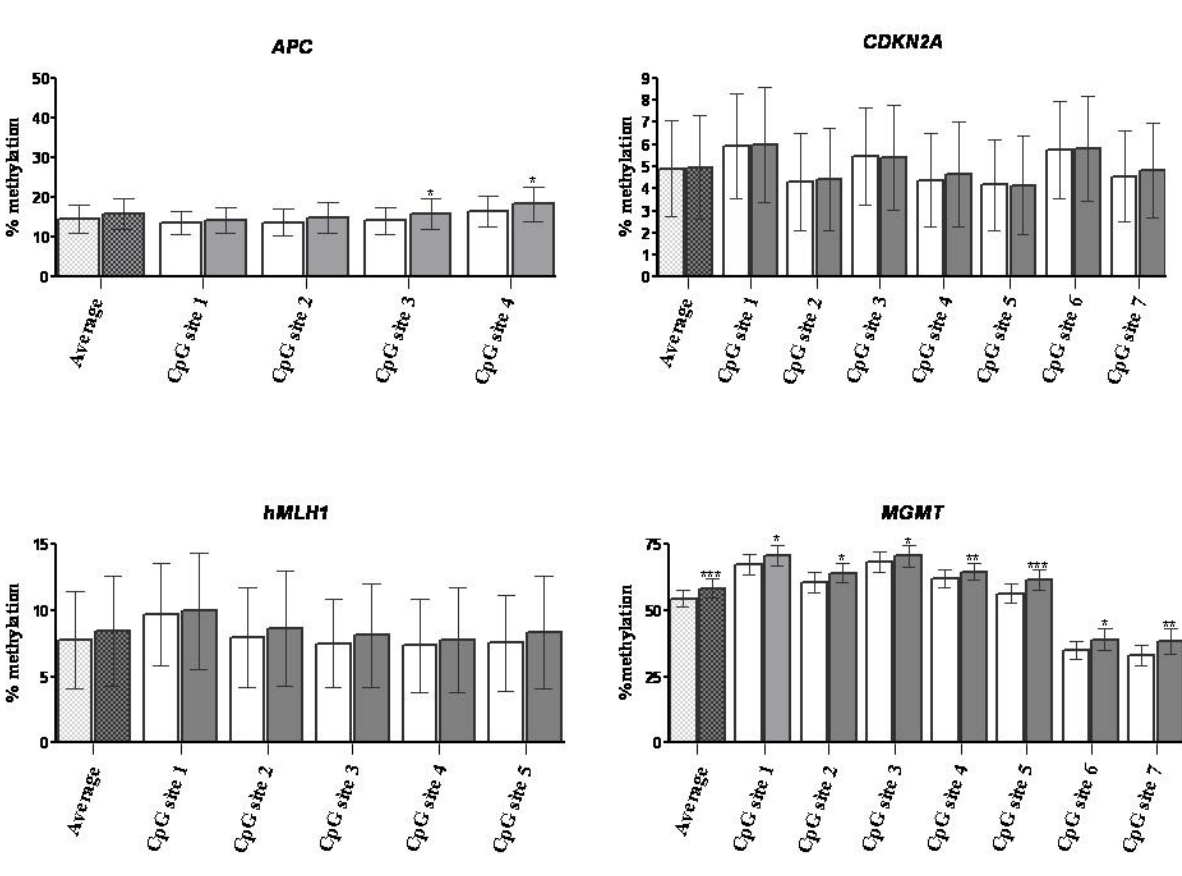
Figure 1. Comparison of the DNA methylation status between EpCAM non-enriched and enriched samples. Methylation of each gene (Average) and of the individual CpG sites was evaluated in 24 CRC patients. The bars represent the mean of the methylation values of each subject analyzed ± the S.E.M. Dark bars indicate EpCAM-enriched